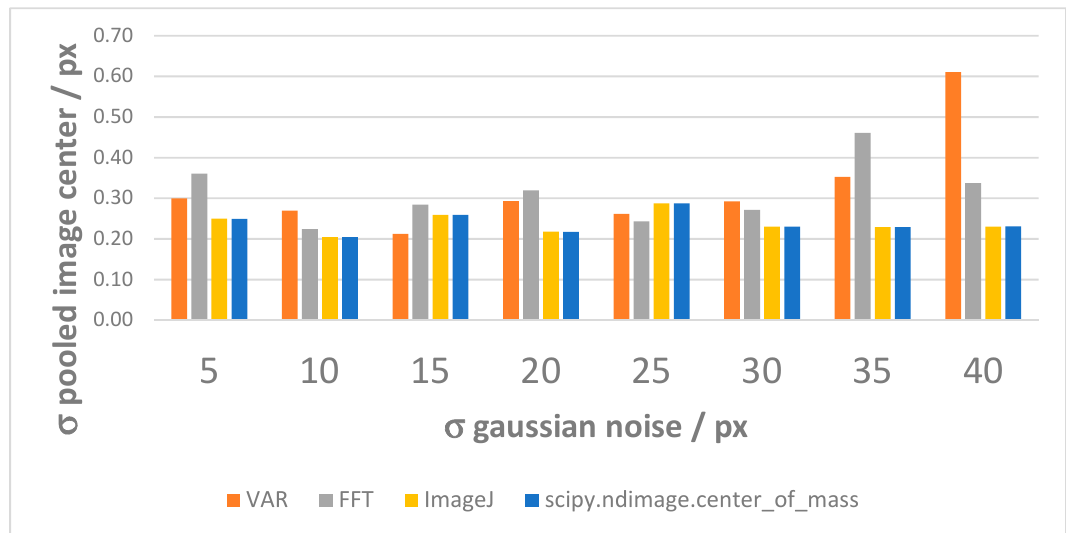
Figure 24. Repeatability of center determination vs. image noise, tested with different algorithms: a representative example (here the distance of 254 mm is investigated).